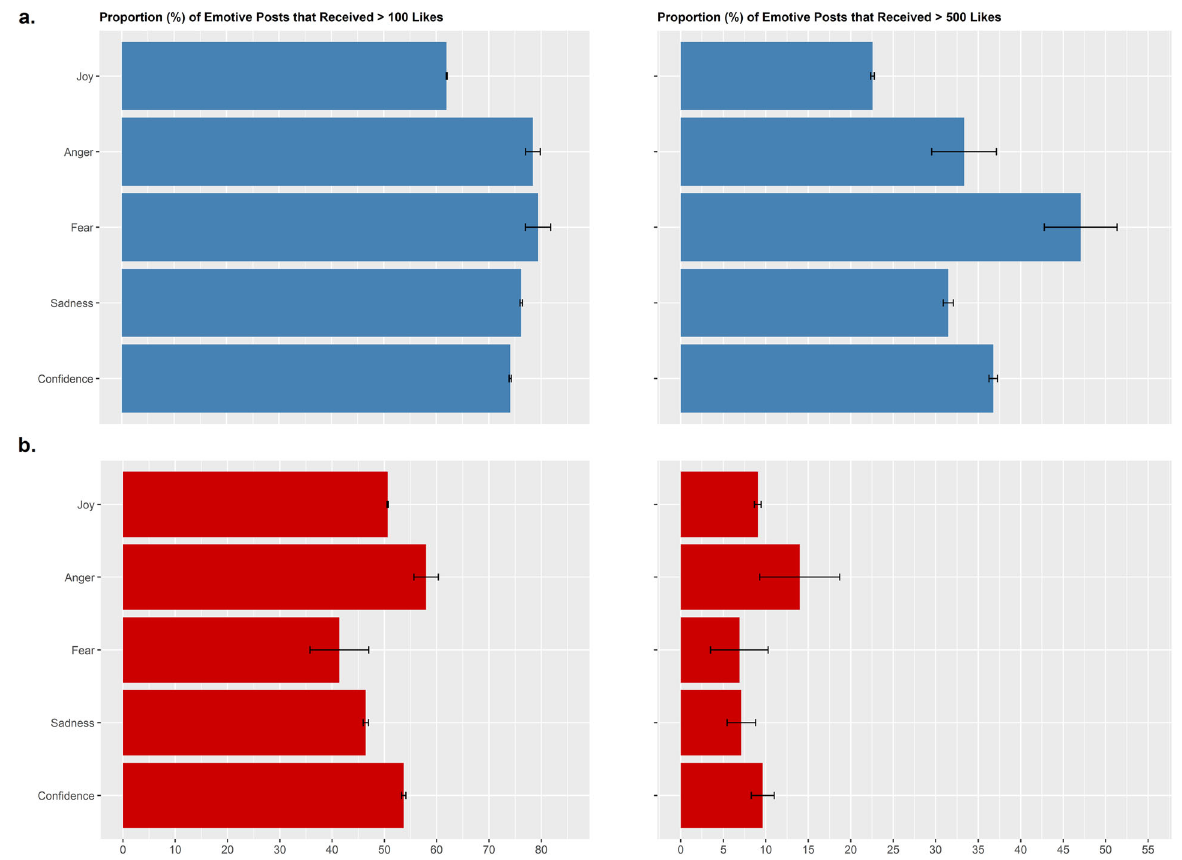
Fig. 2 Favoriting rates of emotionally charged messages. Favoriting rates of messages containing emotional content published by a Democratic vs. b Republican candidates. Error bars are derived to estimate the proportion between the upper and lower limits (proportion ± standard error).